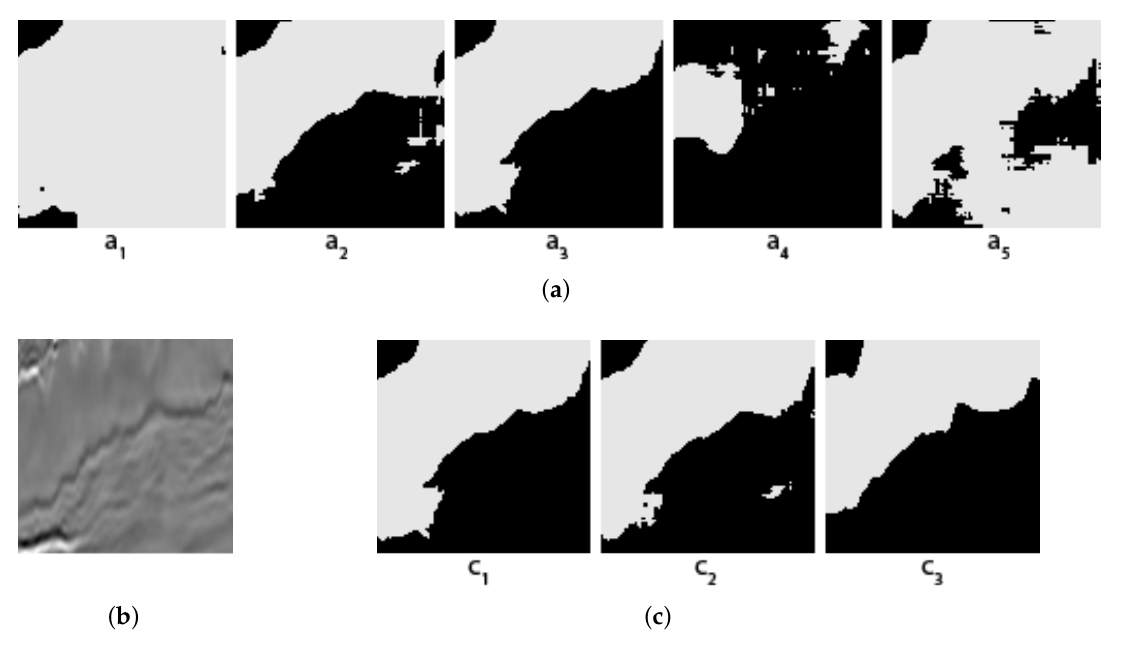
Figure 5. Topological vs. Arithmetical voting in salt segmentation - The third example. ( a ) Masks created by 5 individual segmentors (predictions of the 5 folds); ( b ) Original image; ( c ) C 1 : Topological voting, C 2 : Arithmetical voting, C 3 : True mask.